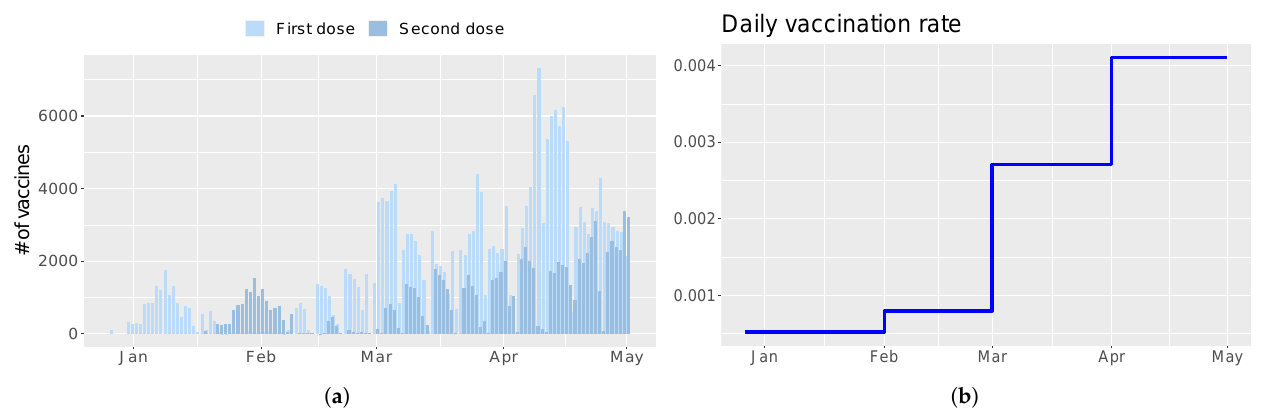
Figure 3. Vaccination campaign in Umbria. ( a ) Number of first (light blue) and second (blue) doses injected every day. ( b ) Profile of the evolution of the vaccination rate η chosen for model calibration. Table 1. CRC results for Umbria and Italy. The second column shows the prior distribution of parameters, set at the beginning of the first CRC iteration. The third and fourth columns show, respectively, the mode vector of f P | P in one of the 10 final realizations for Umbria and Italy. Note O , (cid:101) that the pre-symptomatic period (PresymPeriod) is supposed to be a percentage of the incubation period